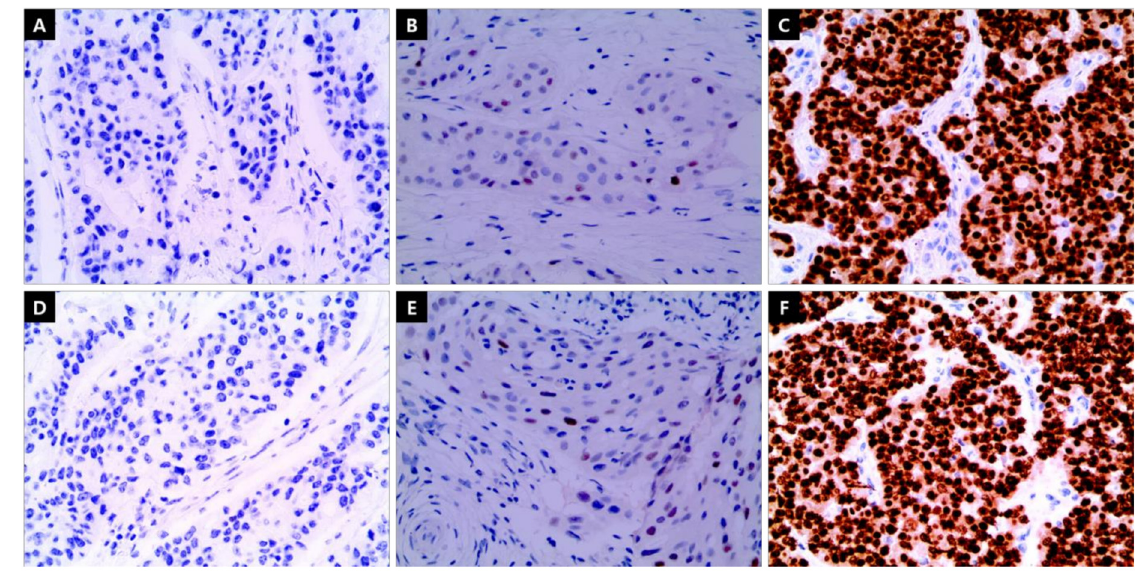
(Figure 3). The negative breast cancer group was defined as patients with breast tumors that were both ER- and PgR-negative. The low group comprised patients with breast tumors with low ER and low/negative PgR or negative ER and a low PgR expression level. The single high group consisted of patients whose tumors had only one of the receptors expressed at a high level; that is, ER > 10% and PgR = 0–20% or ER = 0–10% and PgR > 20%. The both high HR group comprised patients whose tumors expressed high ER (>10%) and high PgR (>20%) levels.